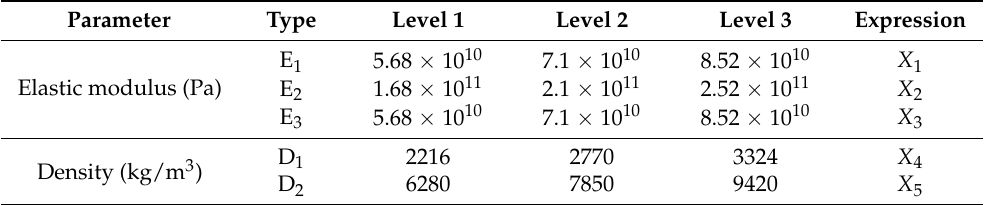
Table 3. Values for each level of the parameters that needed to be corrected.